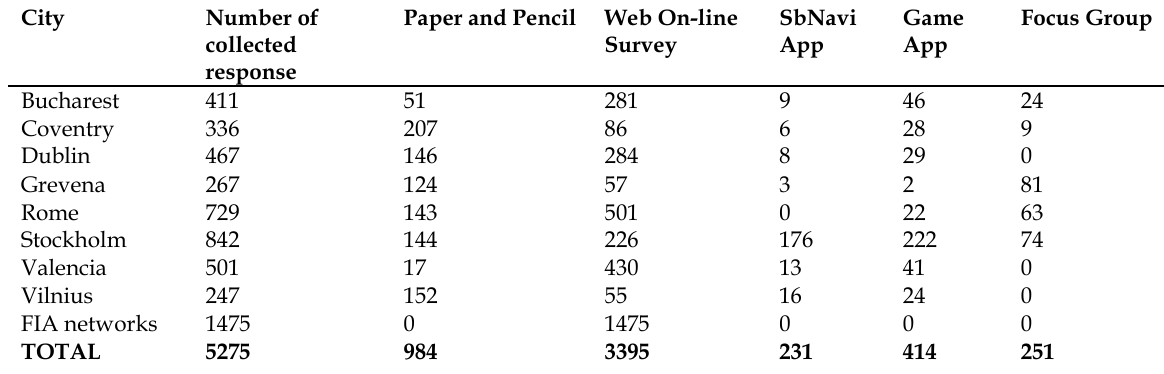
Table 2. Distribution of valid respondents, by socio-demographic characteristics